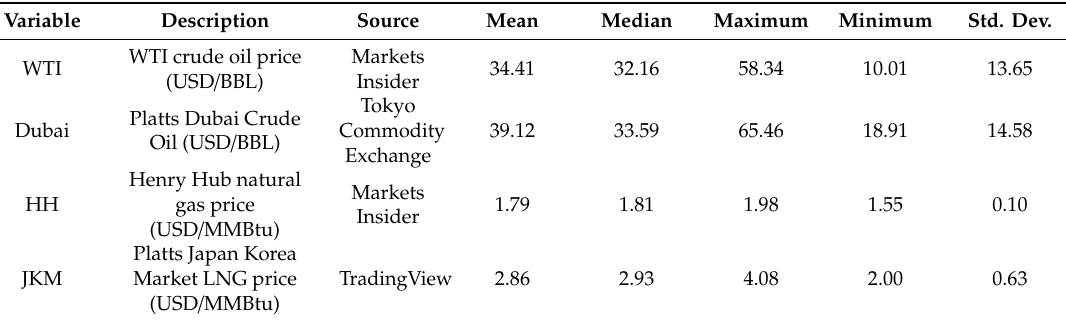
Table 3. Description of